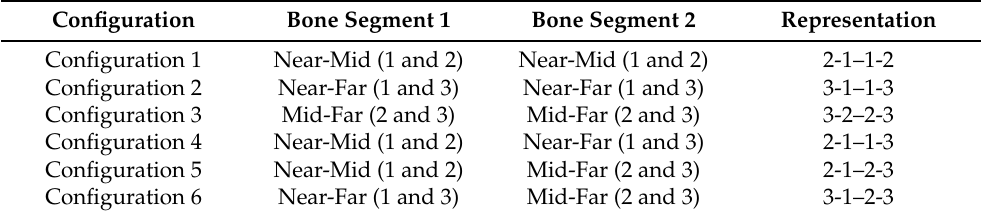
Table 1. List of configurations tested and pin placement position in each configuration.